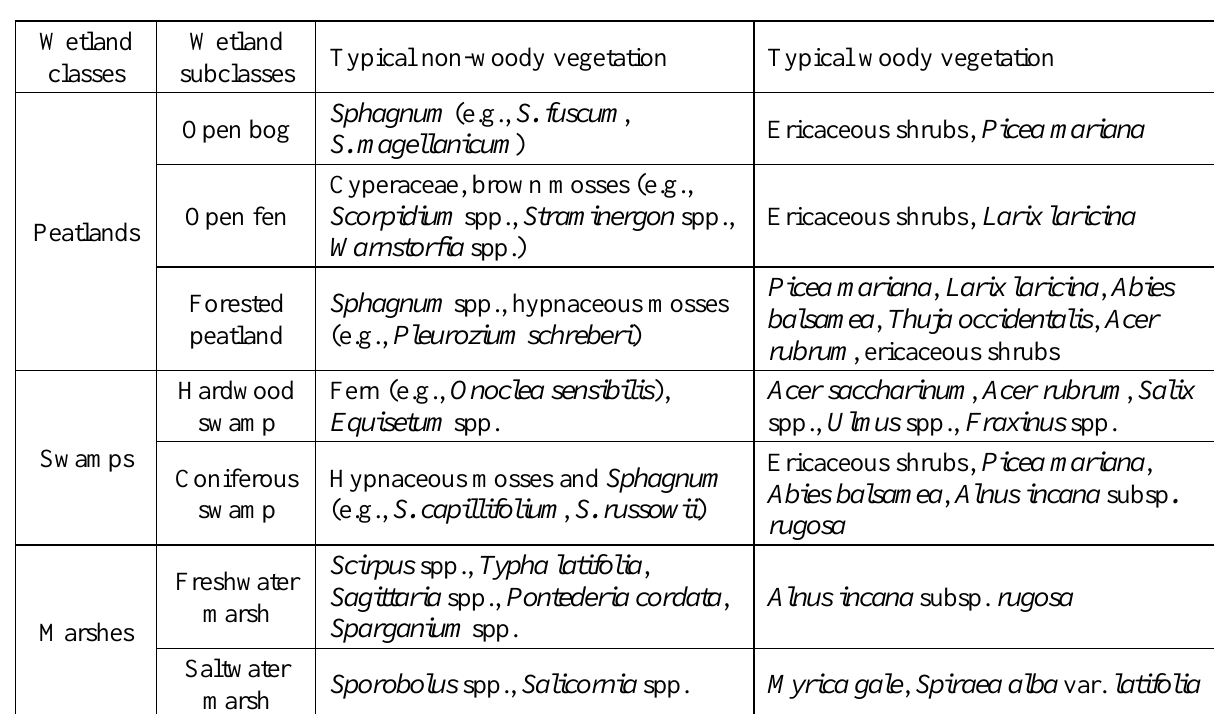
Table 1. Wetland categories in the dataset used for the calculation of SOC densities and SOC masses and their typical vegetation